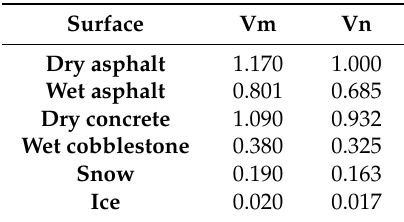
Table 6. Maximum and normalized values.